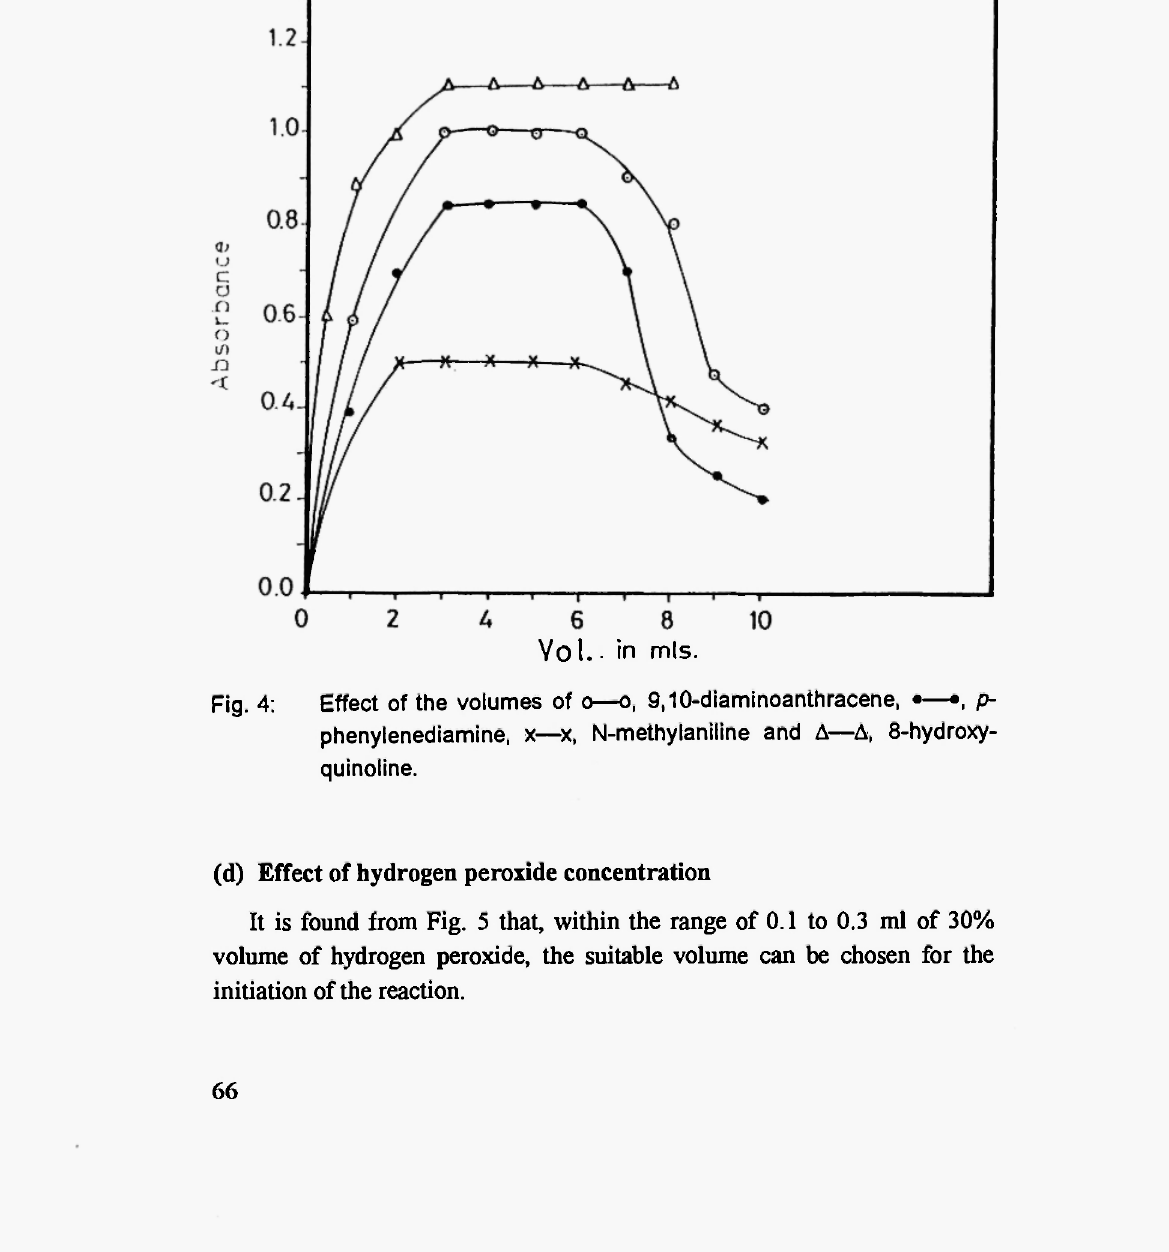
Fig. 4: Effect of the volumes of ο—ο, 9,10-diaminoanthracene, ·—·, p- phenylenediamine, χ—χ, N-methylaniline and Δ—Δ,